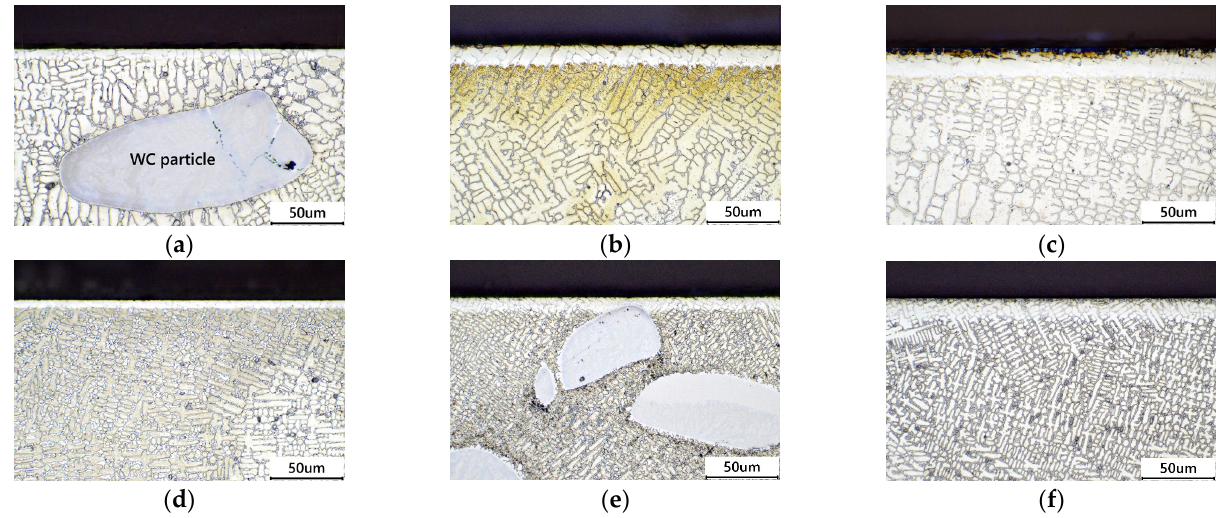
Figure 2. X-ray diffraction patterns of the AISI 316 L steel-based WC composite layers with various WC compositions and nitriding temperatures: ( a ) WC 20 wt.%, and ( b ) WC 40 wt.%.